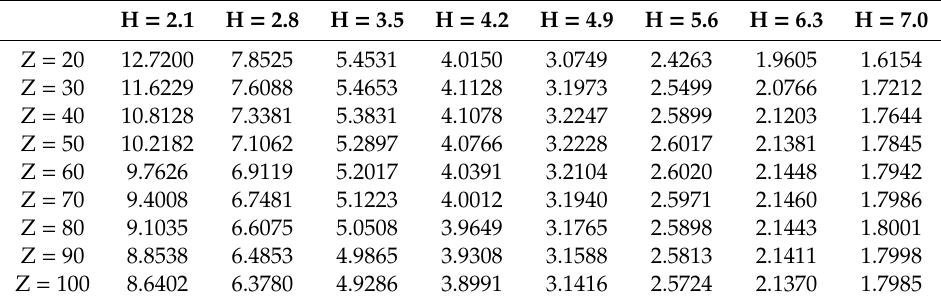
Table 8. A ffi liated body sti ff ness represented by the average value (unit: N / m /